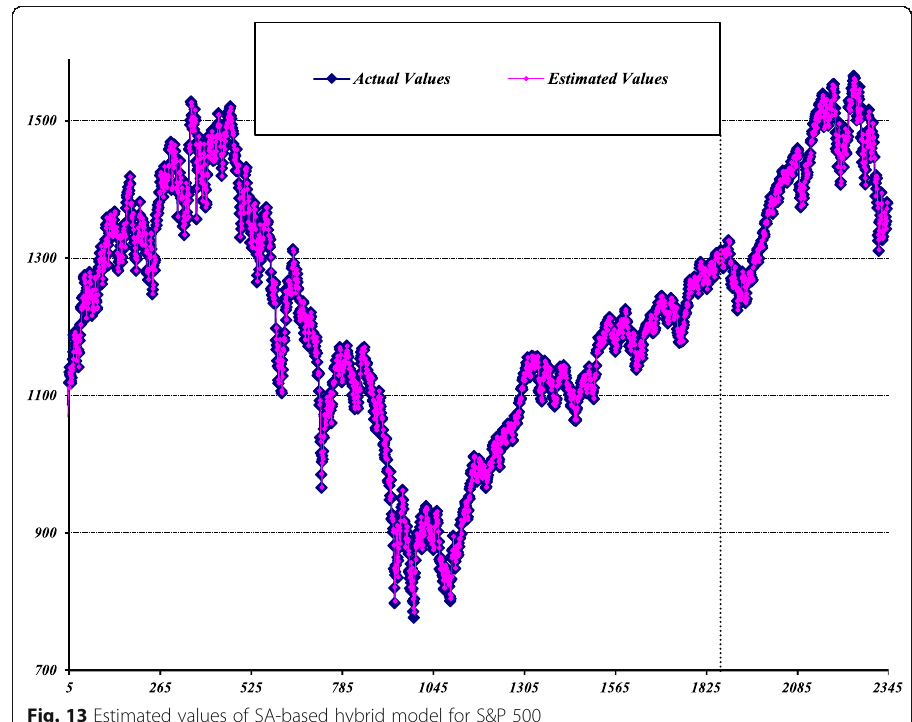
Fig. 13 Estimated values of SA-based hybrid model for S&P 500